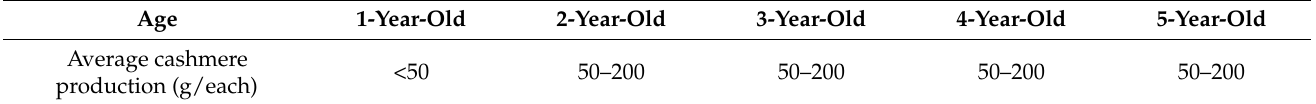
Table 6. Annual production of cashmere in age 1 to 5-year-old Northwestern Tibetan cashmere